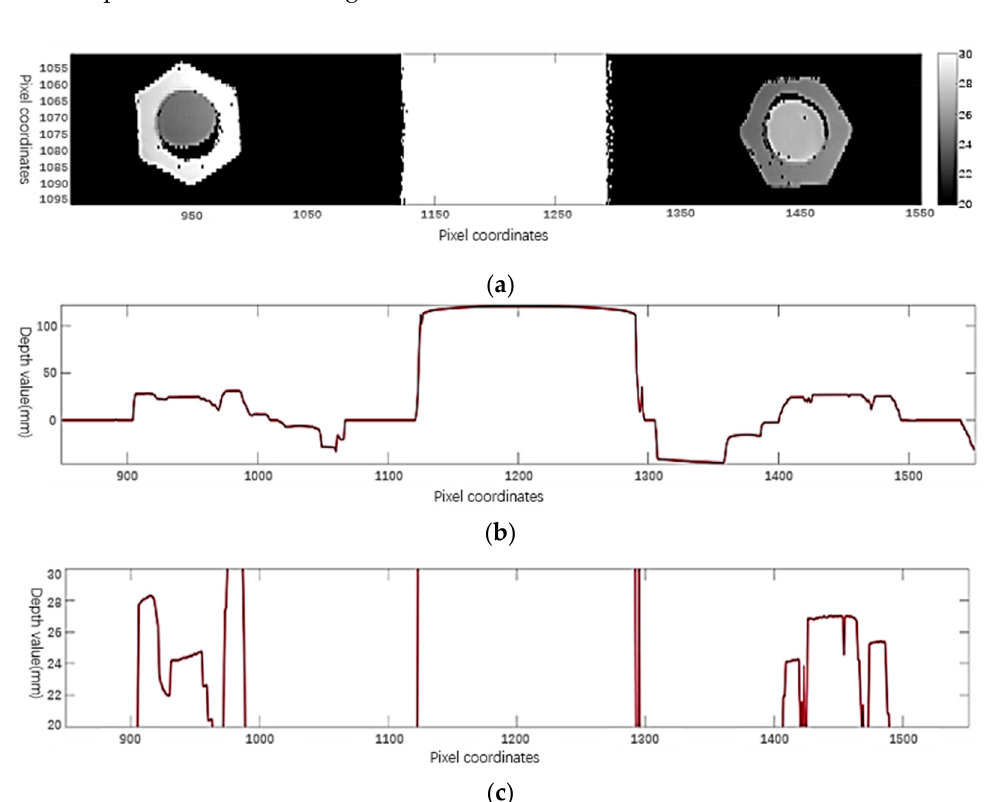
Figure 7. Depth map process: ( a ) Depth map h ( x, y ) of fastener area; ( b ) vertical average value f(x) across the horizontal “narrow band” area of the fastener; ( c ) partial enlarged display of figure ( b ) (the vertical axis ranges from 20 to 30).